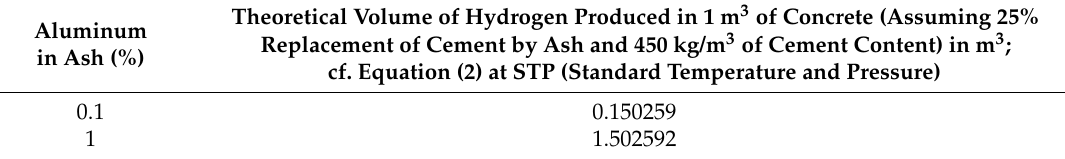
Table 3. Estimation of hydrogen gas